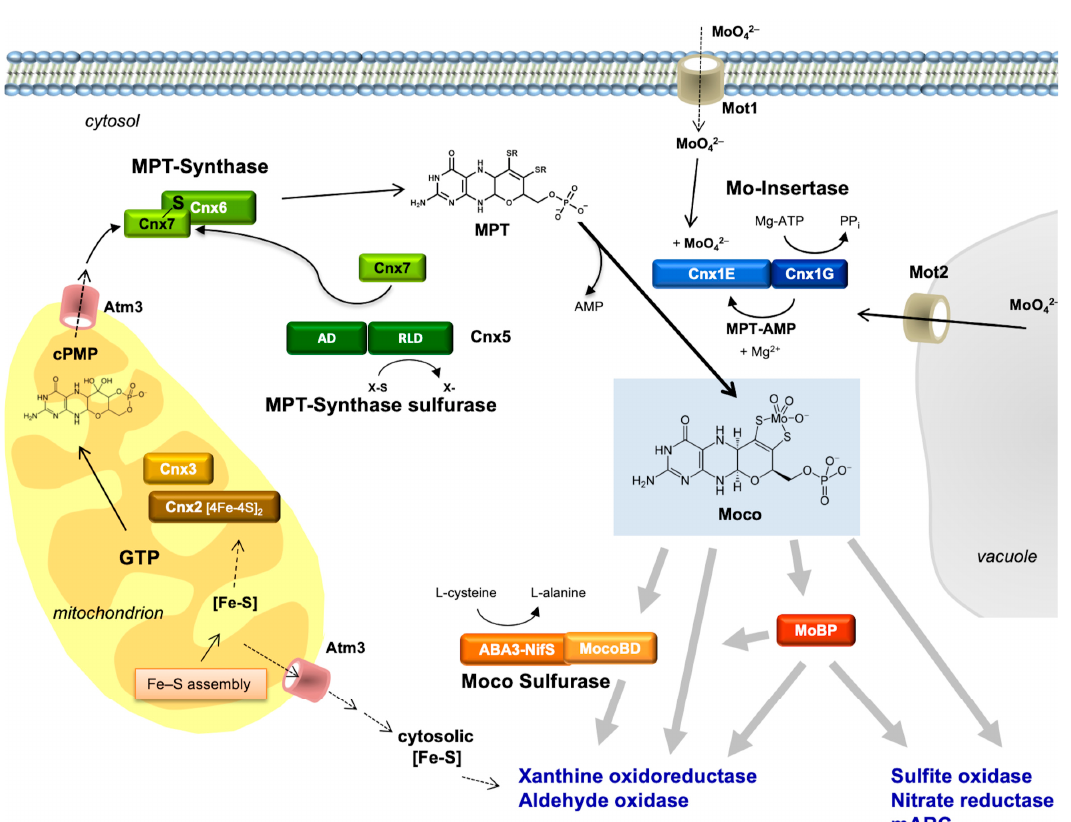
Figure 5. Present model for the biosynthesis, distribution, and maturation of Moco in plant cells. Biosynthesis starts with the conversion of GTP to cPMP in the mitochondria. The dependence of Cnx2 on [Fe–S] is indicated. The transporter Atm3 is assumed to be involved in the export of cPMP to the cytosol [97], where MPT-synthase, consisting of Cnx6 and Cnx7, is sulfurated by Cnx5, with the primary sulfur donor of Cnx5 (X-S) being unknown. The individual reactions of the Mo insertase Cnx1 and its products (Moco, pyrophosphate, and AMP) are indicated. Molybdate for this reaction is supplied by the vacuolar exporter Mot2 (a Mot2-mutant leads to a shortage of molybdate in the